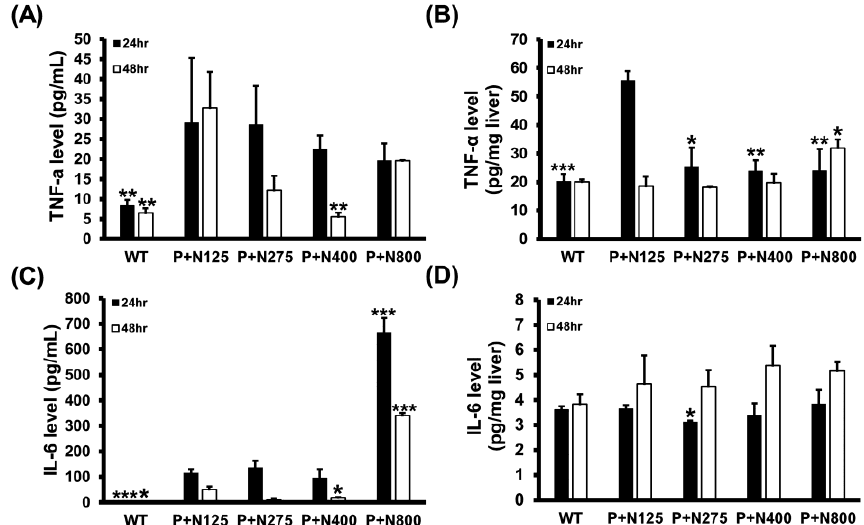
Figure 5. Effects of different doses of NAC therapies on serum ( A , C ) and hepatic ( B , D ) levels of tumor necrosis factor (TNF)-α (A,B) and IL-6 ( C , D ) at 24 h and 48 h post-propacetamol injection in BALB/c mice. Significant differences compared with the P+N125 group are indicated by * ( p < 0.05), ** (p < 0.01), and *** (p < 0.001).